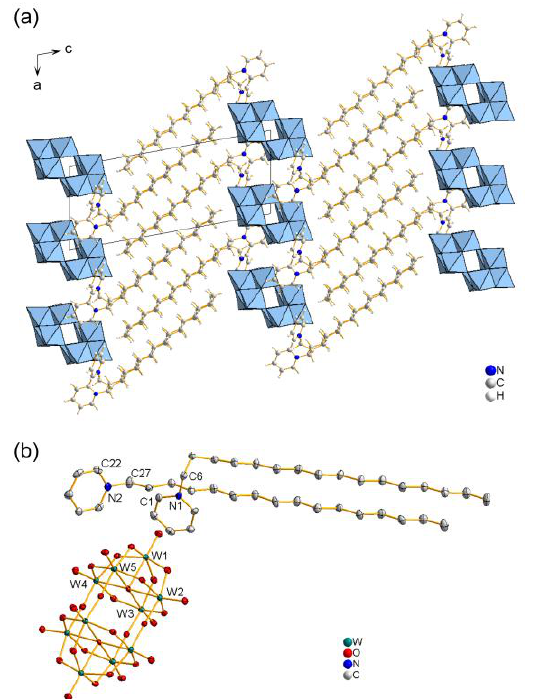
Figure 1. Crystal structure of C polyhedral representations); ( b ) Asymmetric unit together with atoms generated by the symmetry operation (− x , − y , − z ,) to complete W at the 30% probability level, and H atoms are omitted for